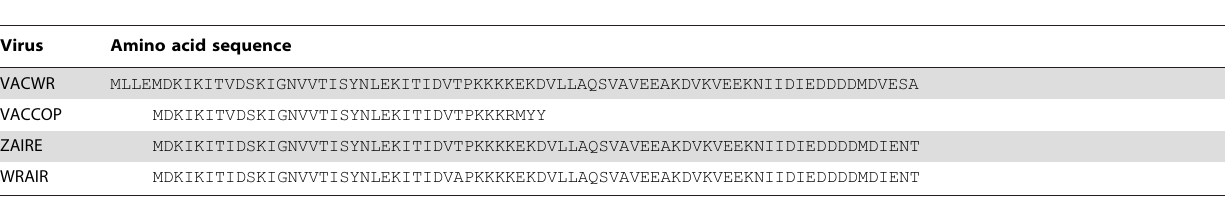
Table 6. Protein A44R of monkeypox and vaccinia